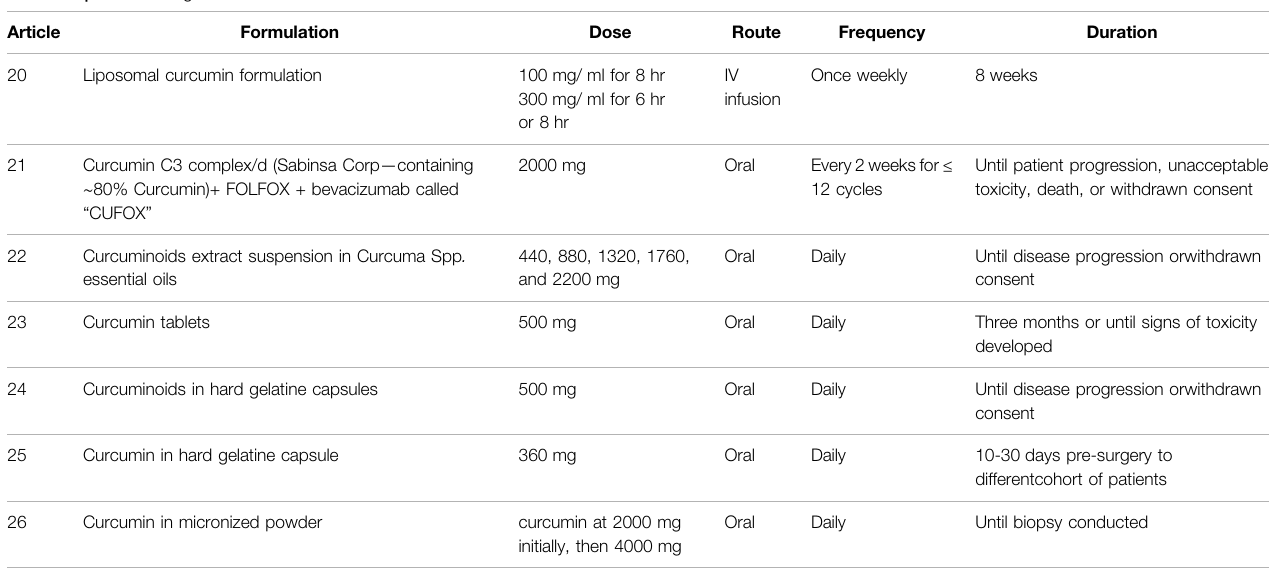
TABLE 3 | curcumin regimen in studied